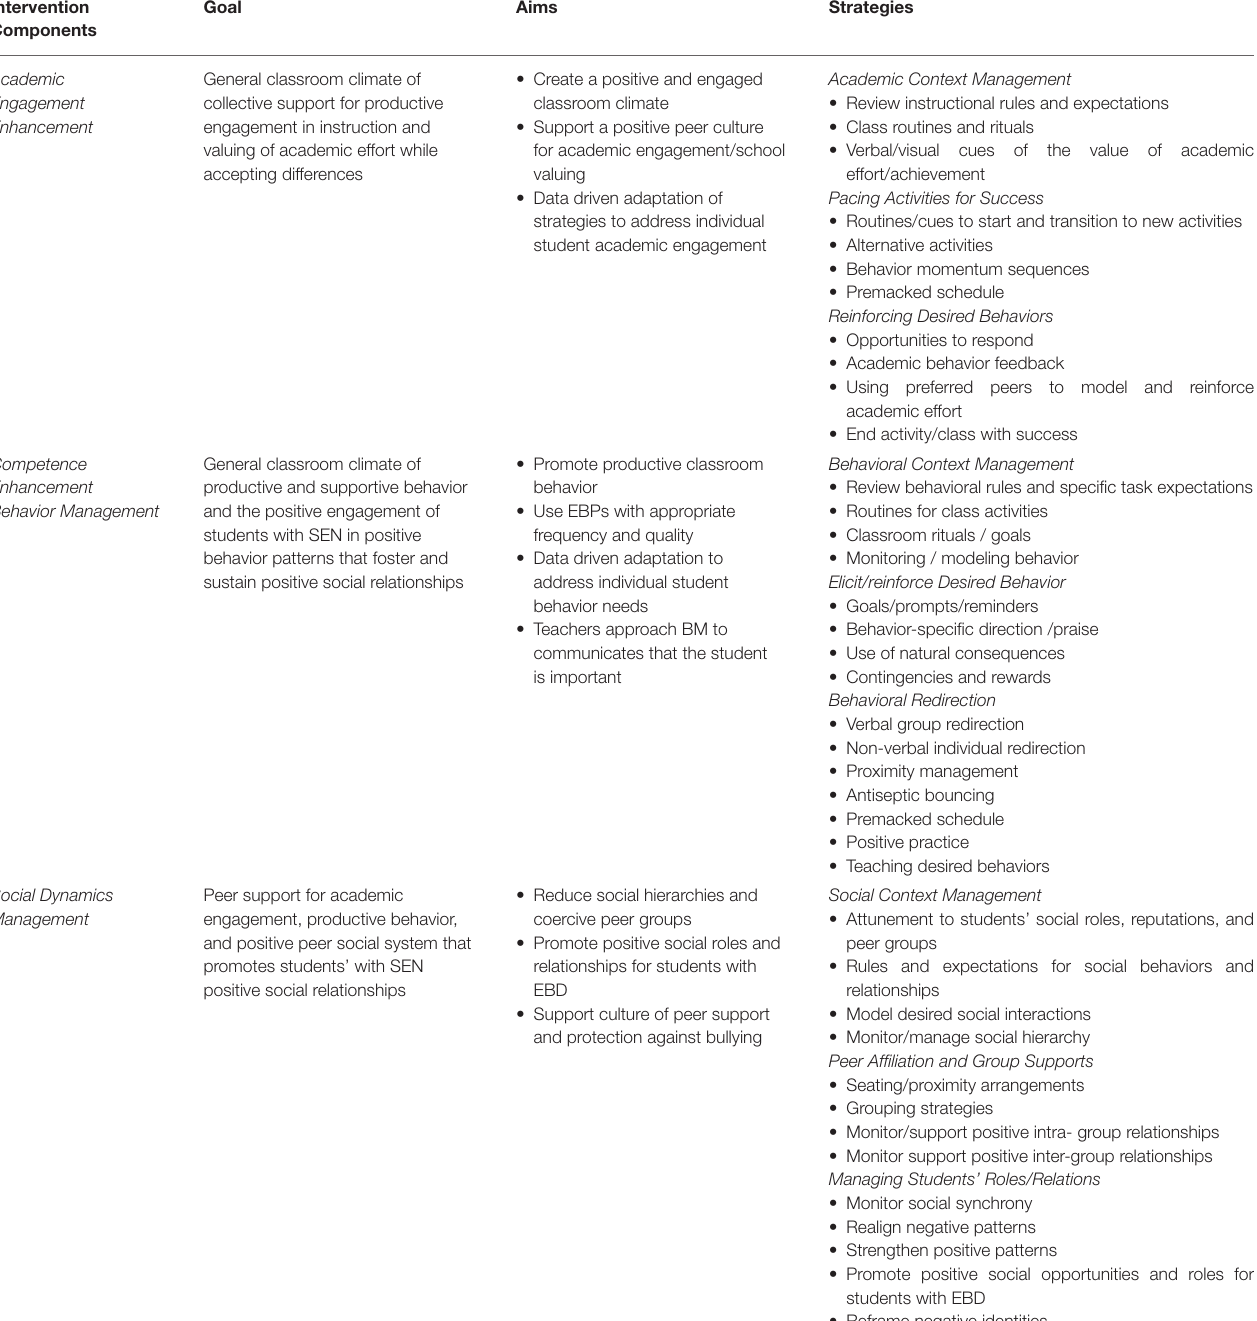
TABLE 1 | Intervention Component Goals, Aims, and